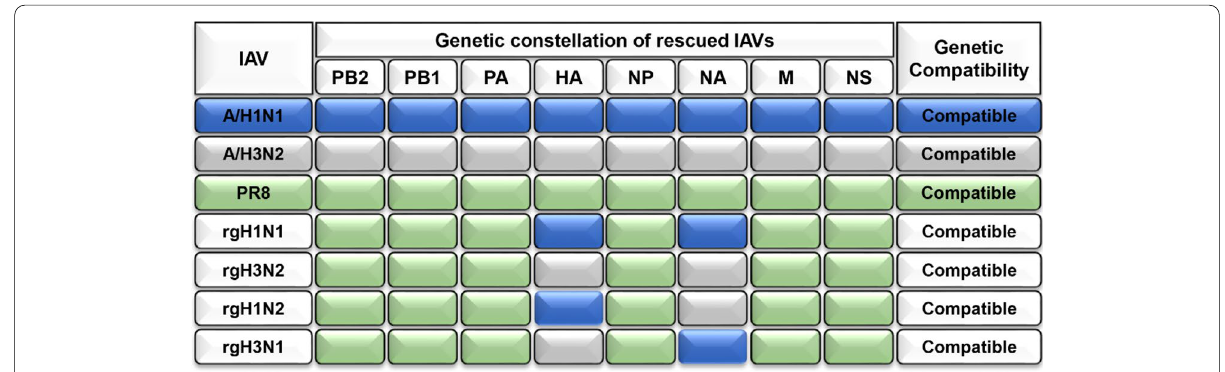
Fig. 1 Genetic illustration of rescued viruses that were tested as candidate vaccine seed strains and their parent